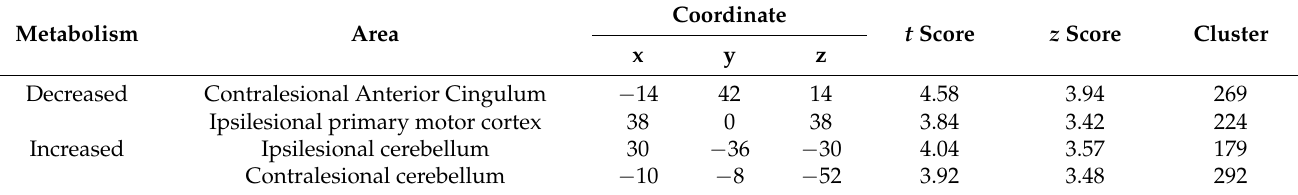
NRS, numeric rating scale.